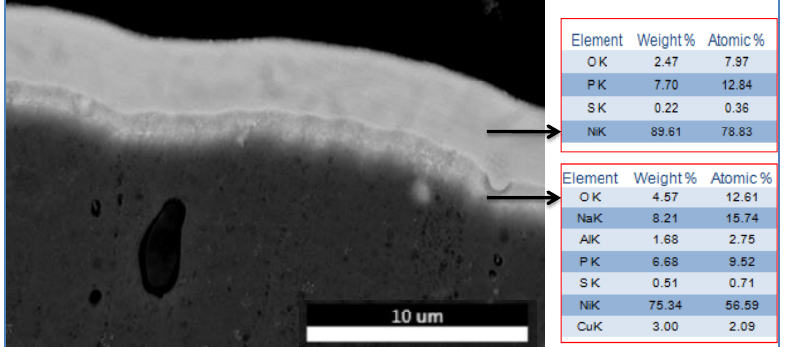
Figure 16: One representative SEM image showing coating on the connectors along with corresponding EDS analysis, Etchant: Keller’s